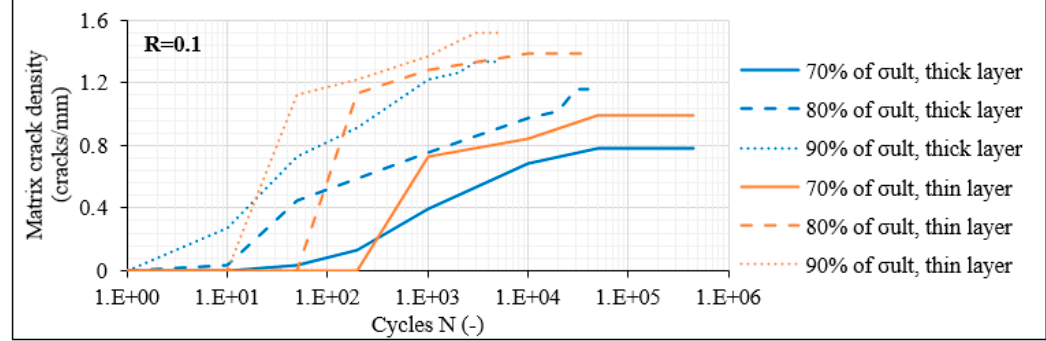
Figure 15. Matrix crack density versus N in [0°/30°] 2s laminates for R = 0.1.